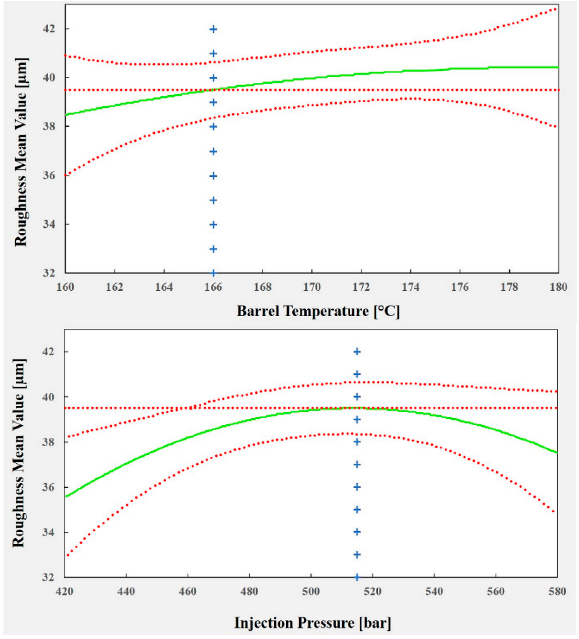
Table 3. Analysis of variance (ANOVA) for obtainable roughness